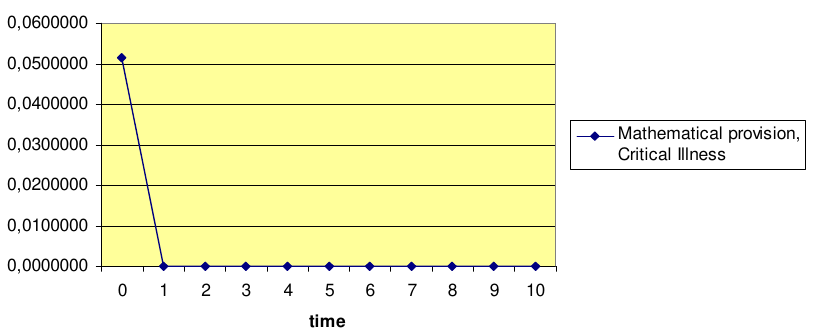
Fig. 9. Mathematical provision critical illness cover, 10 years – Poisson LC decomposition by cause (circulator system)